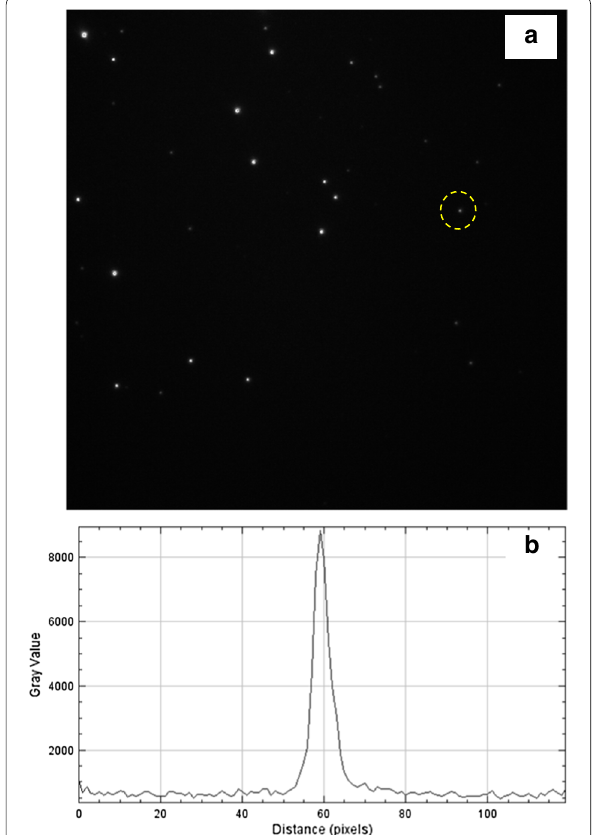
Fig. 10 Wide-field fluorescent image of isolated D19 particles obtained by confocal epifluorescence microscopy ( a ), and the intensity profile of the selected nanoparticle marked by the yellow circle ( b ). Image size: ~ 80 80 mμ. One pixel corresponds to 80 ×